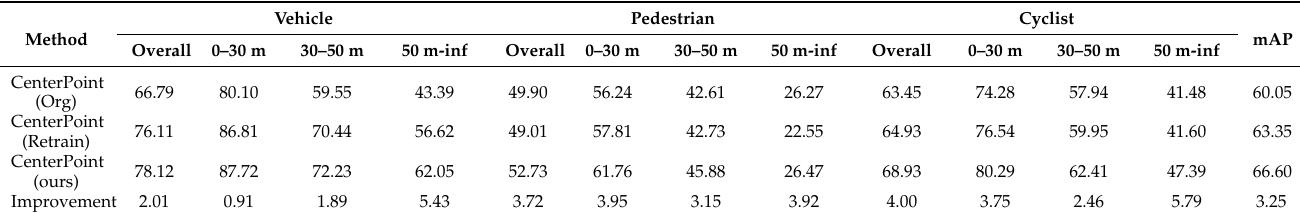
Table 3. Comparison of object detection accuracy of CenterPoint-FE algorithm